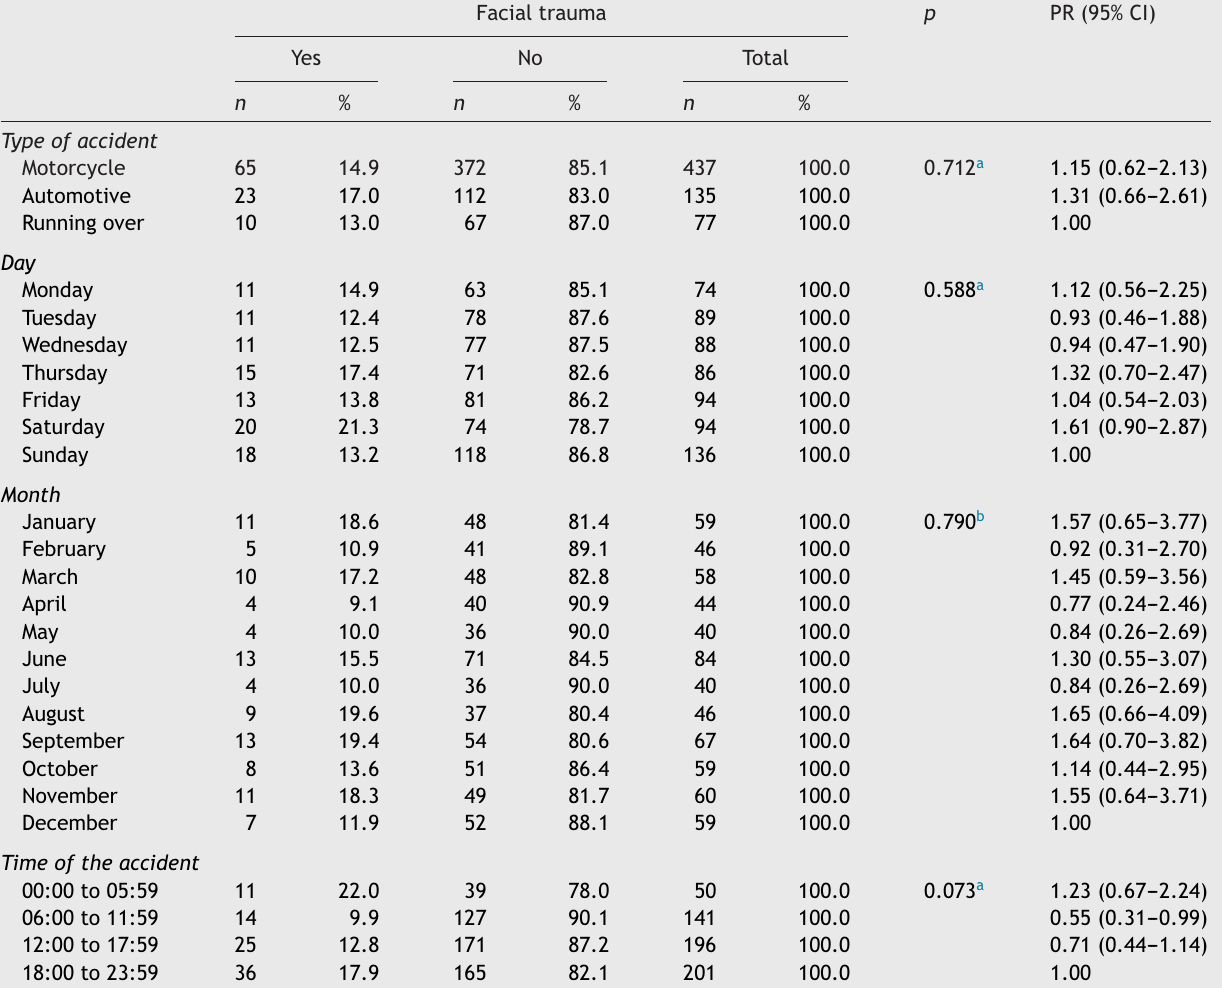
Bivariate analysis between facial trauma and data related to the occurrence of terrestrial transport accidents. Facial trauma p PR (95% CI)